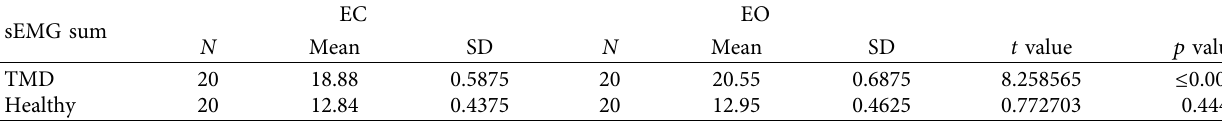
Table 3: EMG values with eyes closed versus eyes open for the two groups.